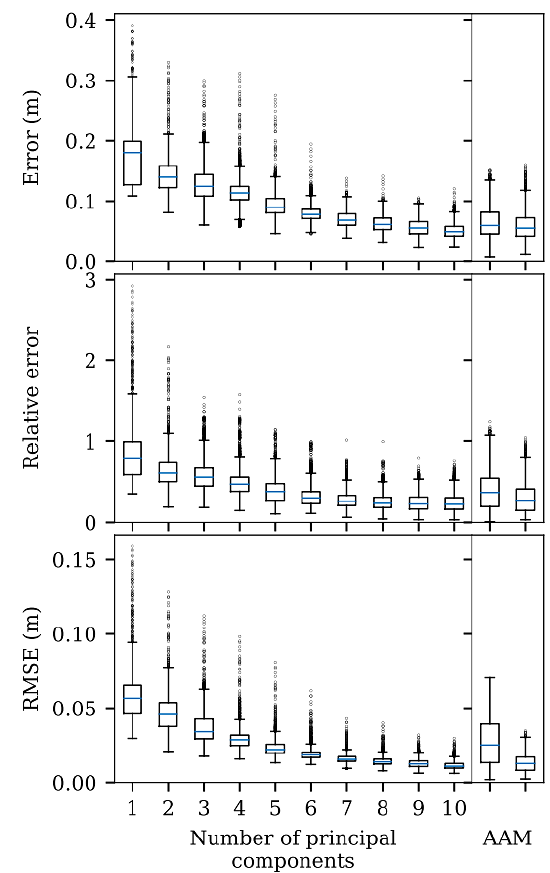
Figure 6. One dimensional cross-sections of the AAM projection space. Top: grey dots locate train and test trajectories in the AAM projection space; circles (resp. triangles) are located on arbitrary lines to illustrate the effect of varying the 1st (resp. 2nd) projection score. Middle (resp. bottom): reconstructed trajectories corresponding to the circle (resp. triangles) of same tint in the top